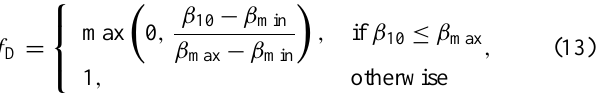
Lower threshold of drought limit for herbs Upper threshold of drought limit for